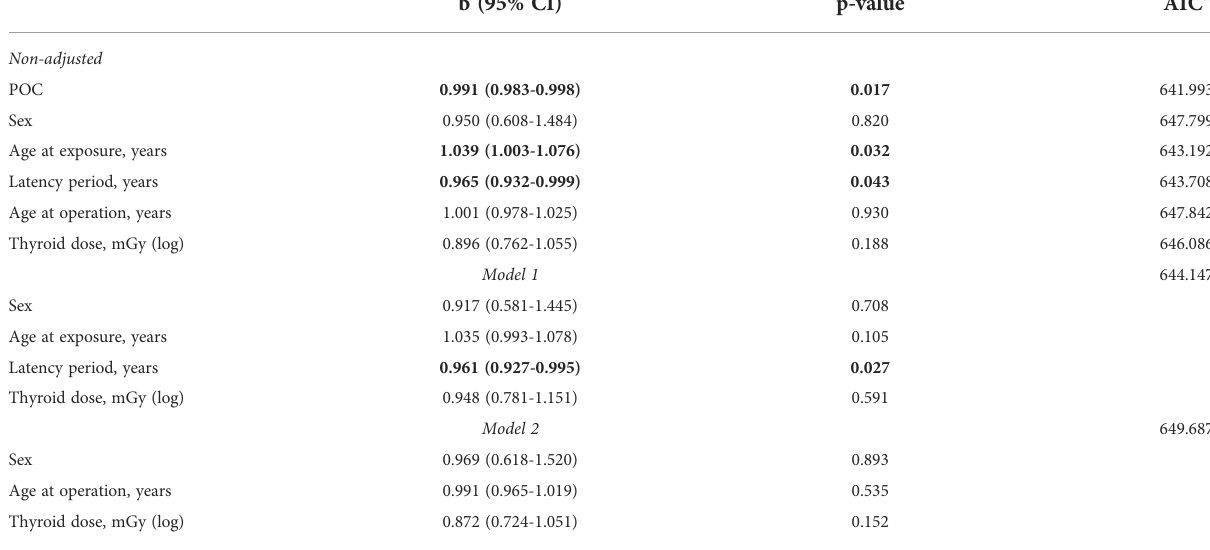
TABLE 5 Effects of POC or its components on tumor size (greater than